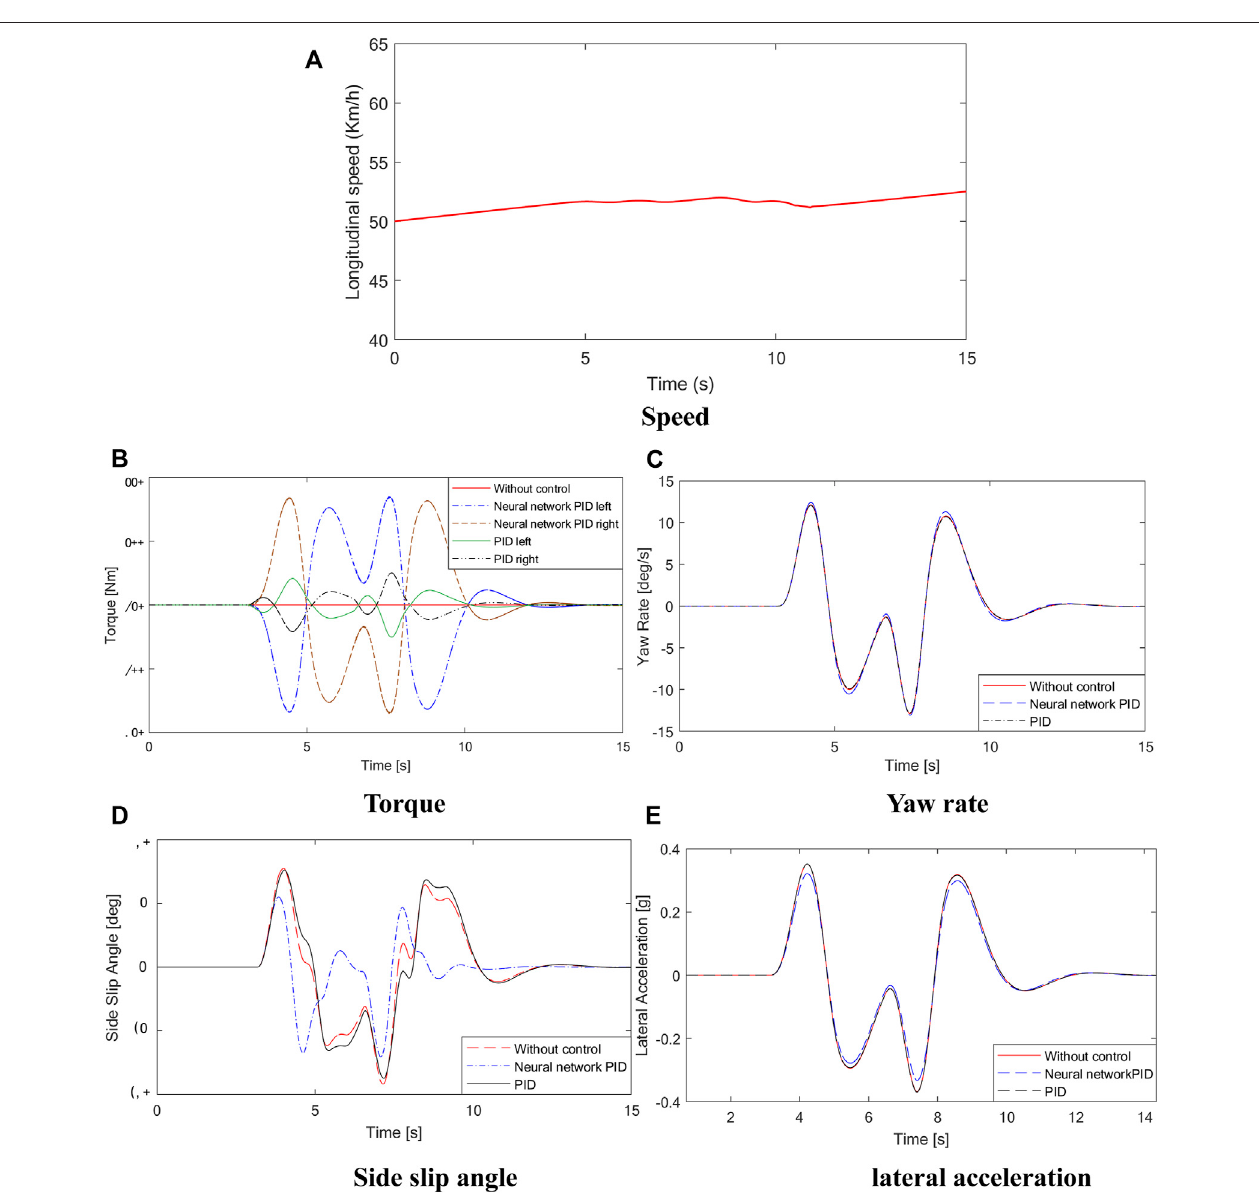
FIGURE 8 | Simulation results. (A) is the longitudinal speed curve, (B) is the torque curve, (C) is the yaw rate curve, (D) is the side slip angle curve, (E) is the lateral acceleration